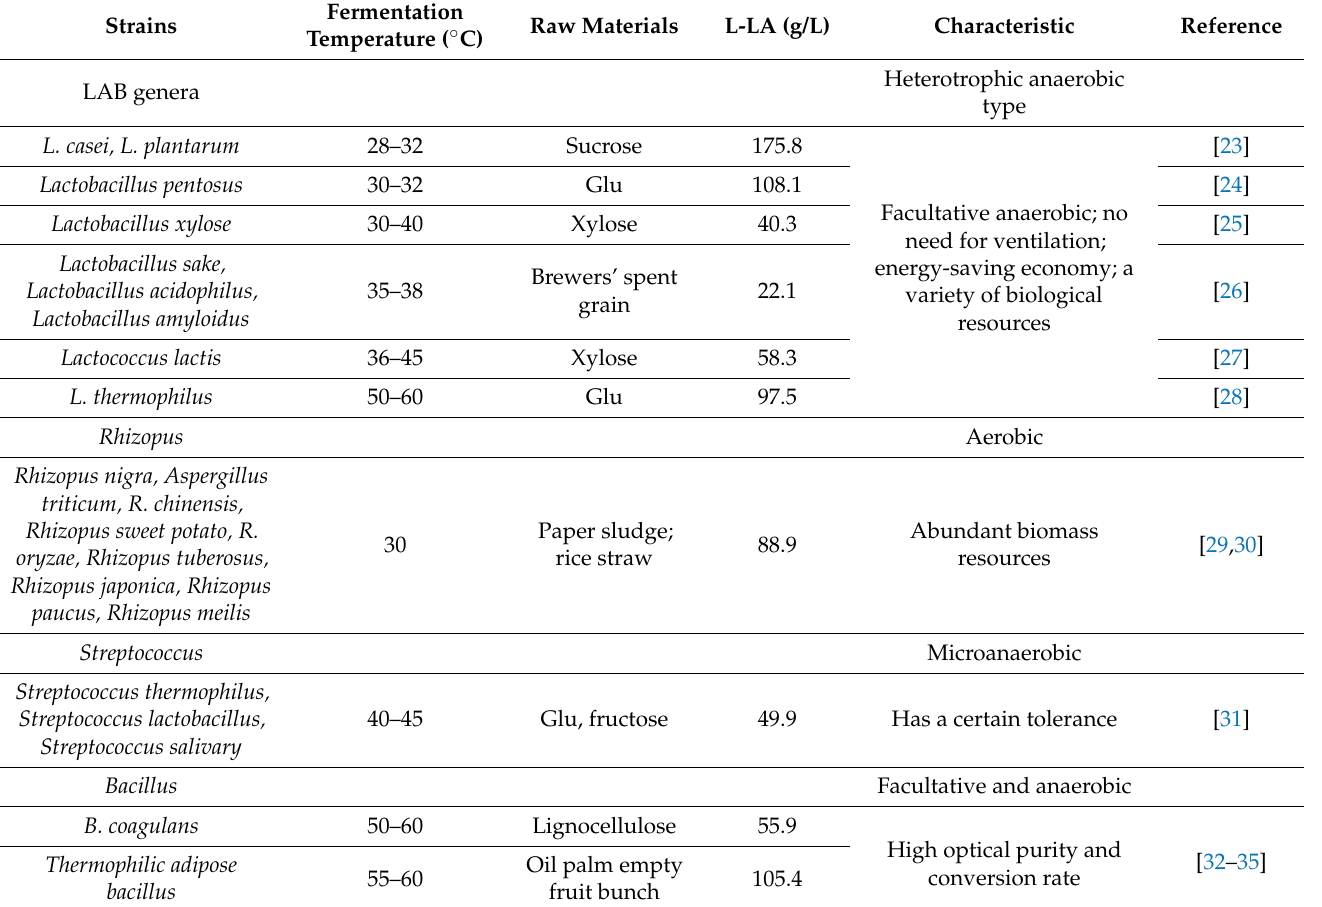
Table 1. Microbial strains producing